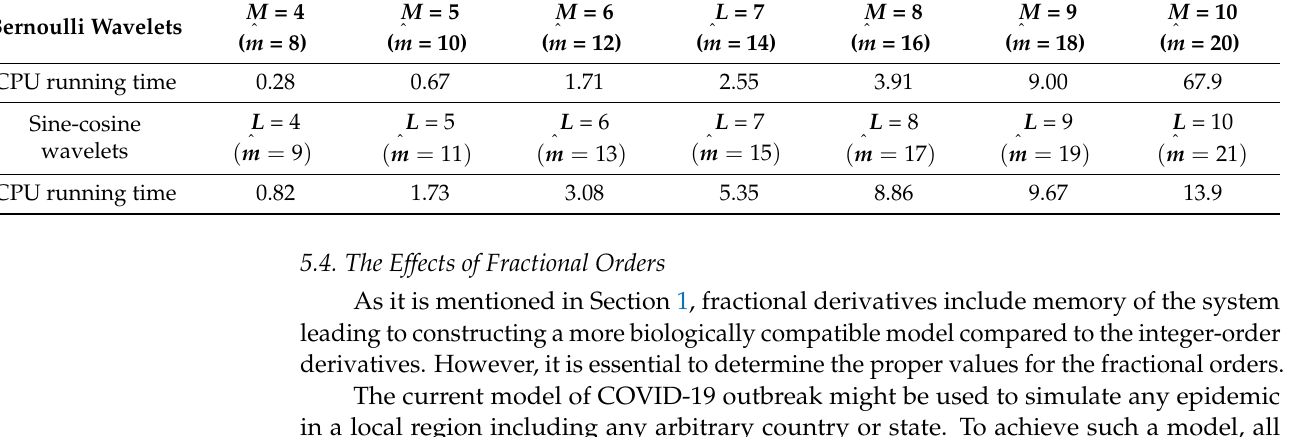
Table 14. Comparison of CPU running time in seconds, used in Bernoulli for k = 2 and sine–cosine wavelets for k = 0. Bernoulli